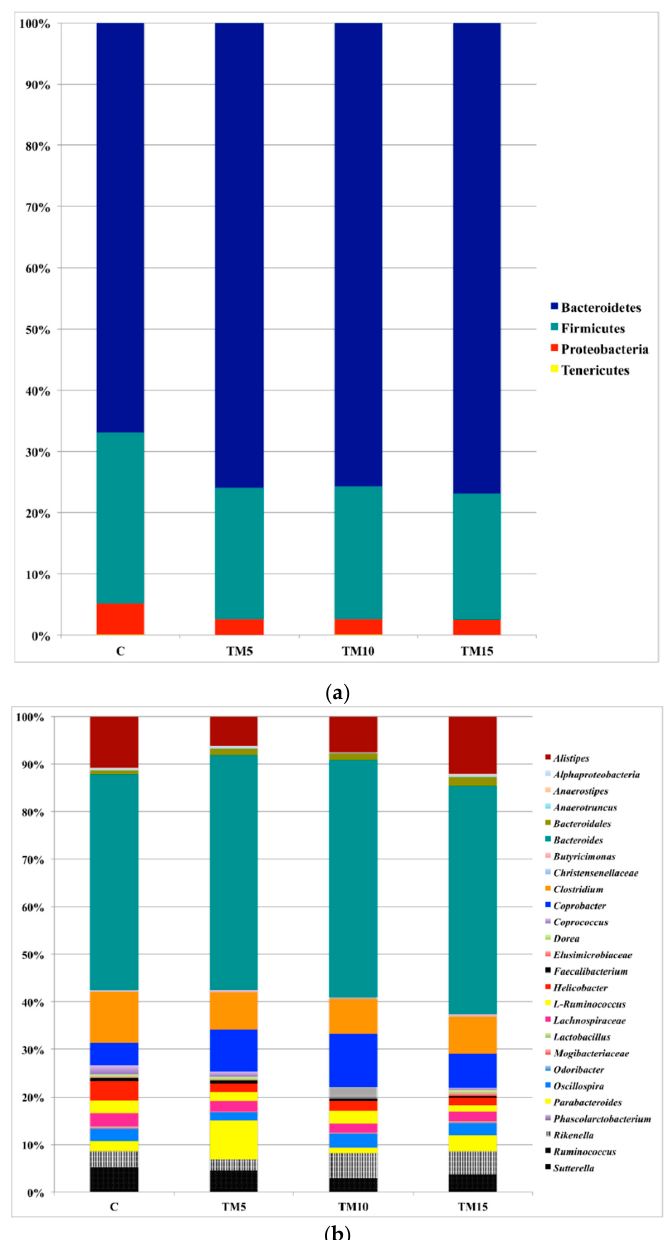
Figure 2. Relative abundance of the main bacterial phyla ( a ) and genera ( b ) in cecal samples of male broiler chickens fed with control (C), 5% (TM5), 10% (TM10) and 15% (TM15) inclusion level of Tenebrio molitor meal diets.